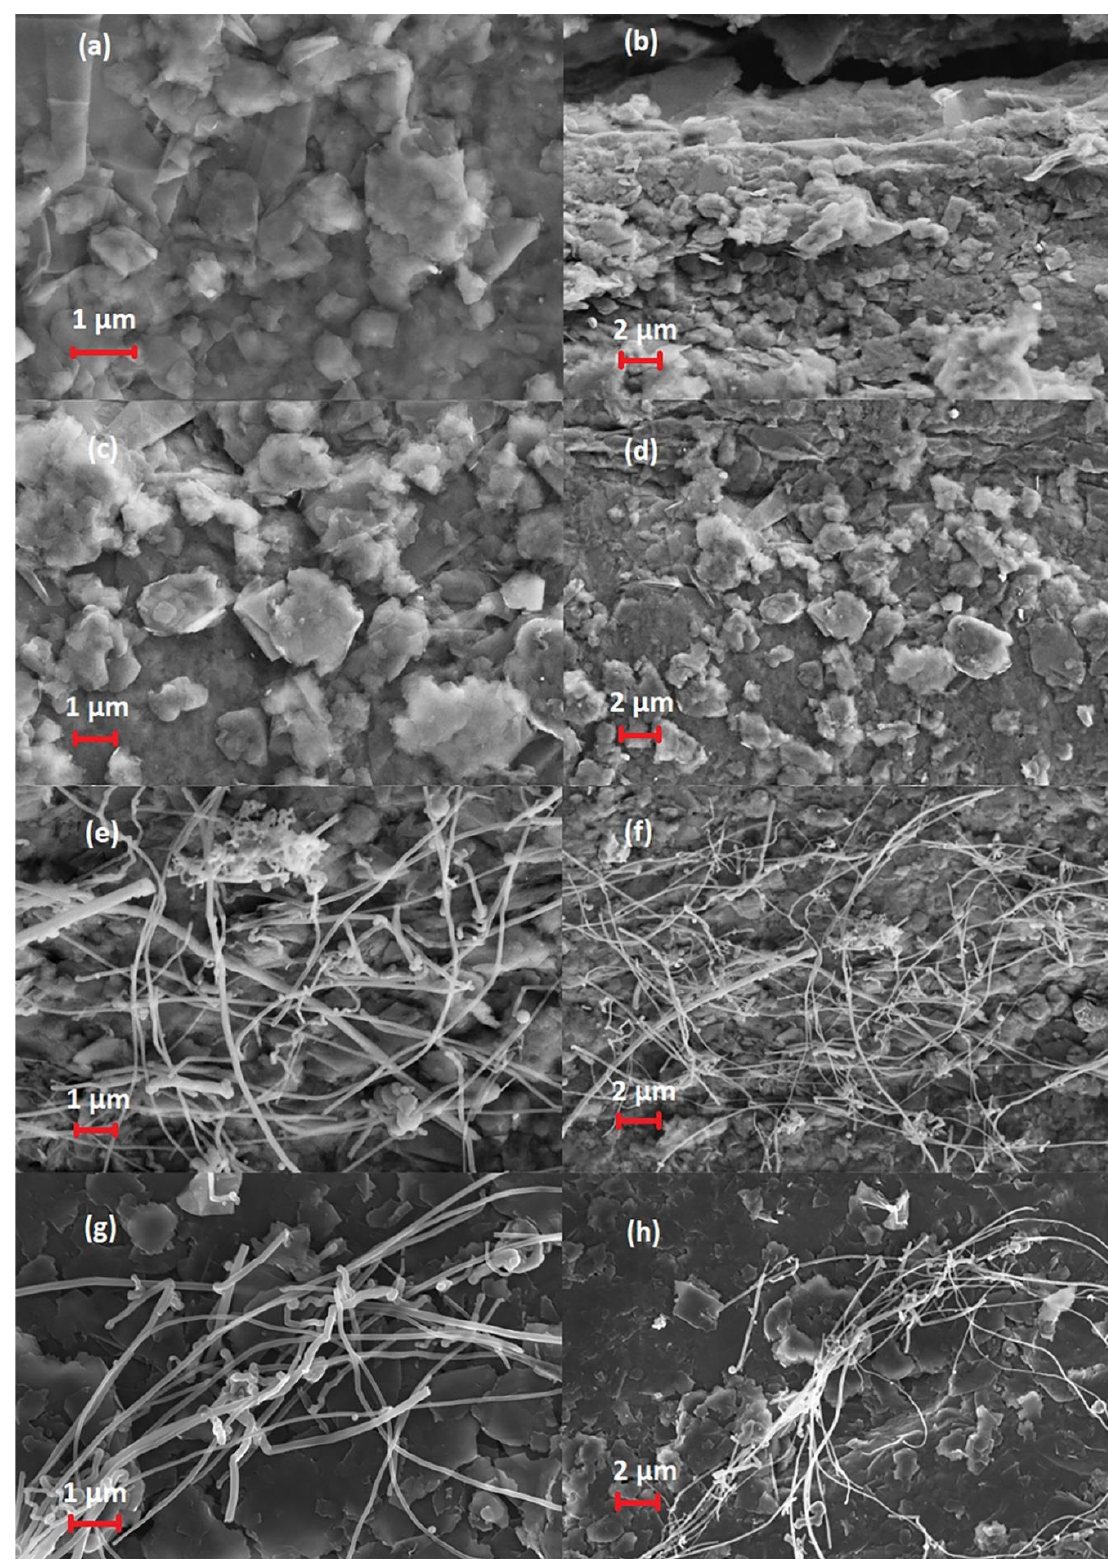
Figure 1. SEM images of unmodified PGE ( a , b ), IL/PGE ( c , d ), CNF/PGE ( e , f ) CNF - IL/PGE ( g , h ) using the identical acceleration voltage as 5.0 kV with resolution 1 μm and 2 μm, respectively. The sheeted graphite structure of PGE was observed as shown in Figure 1a,b. After ionic liquid modification onto the surface of PGE, a less rough surface of the electrode